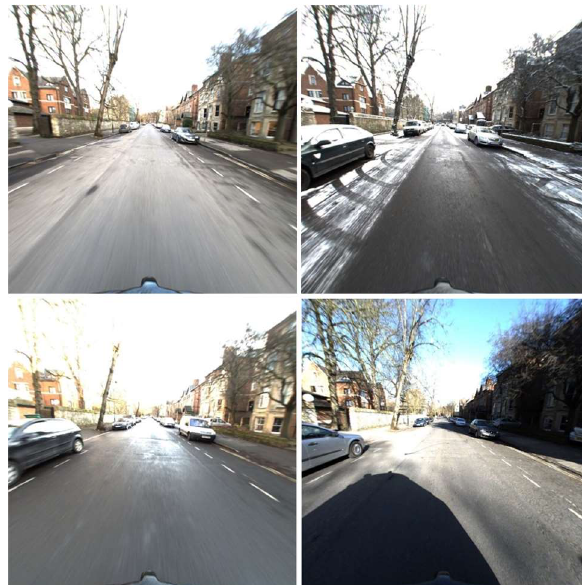
Figure 2. Four images of the Robot Car Seasons dataset depicting the same location in different conditions By matching the same images multiple times with different parametrization of the matcher, we showed that relaxing the restrictions for outlier filtering results in more matches. However, just means they are outliers that got rejected for some reason.